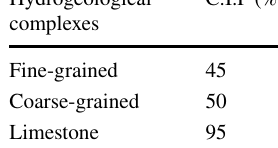
Table 2 C.I.P values (Celico